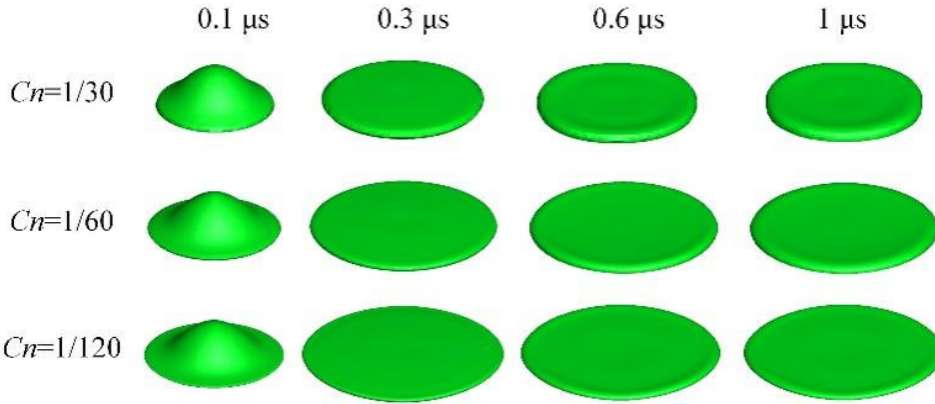
Figure 2. Mesh independence test: spreading and solidification.